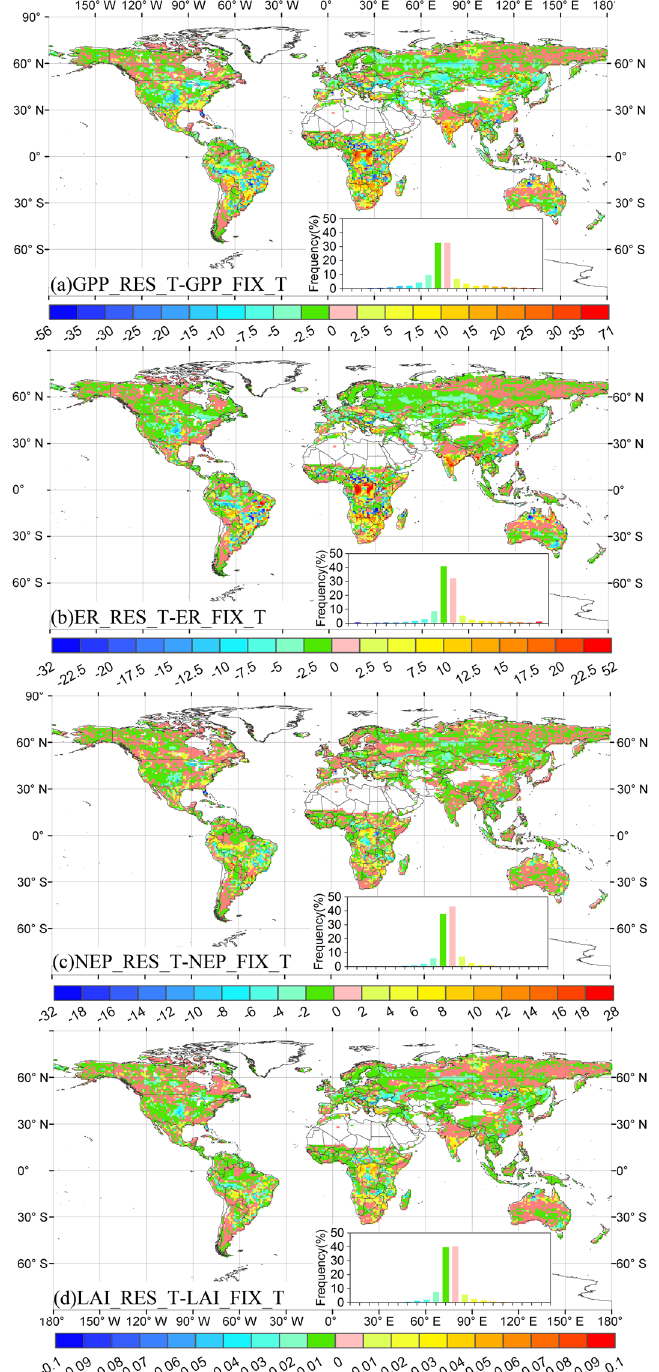
Figure 5. Differences in the trends in gross primary production (GPP, g C m − 2 yr − 2 ), ecosystem respiration (ER, g C m − 2 yr − 2 ), net ecosystem productivity (NEP, g C m − 2 yr − 2 ), and leaf area index (LAI) between CABLE using the resource limitation (RES_T) and fixed coefficient (FIX_T) carbon allocation models during 1979– 2014. The insets show the frequency distributions of the corresponding trends. The maps were created by the ArcMap